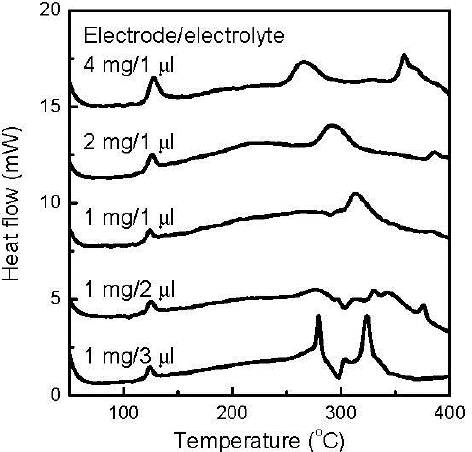
Figure 5. DSC curves of discharged FeOF cathodes down to 1.3 V with associated electrolytes in various cathode/electrolyte ratios.